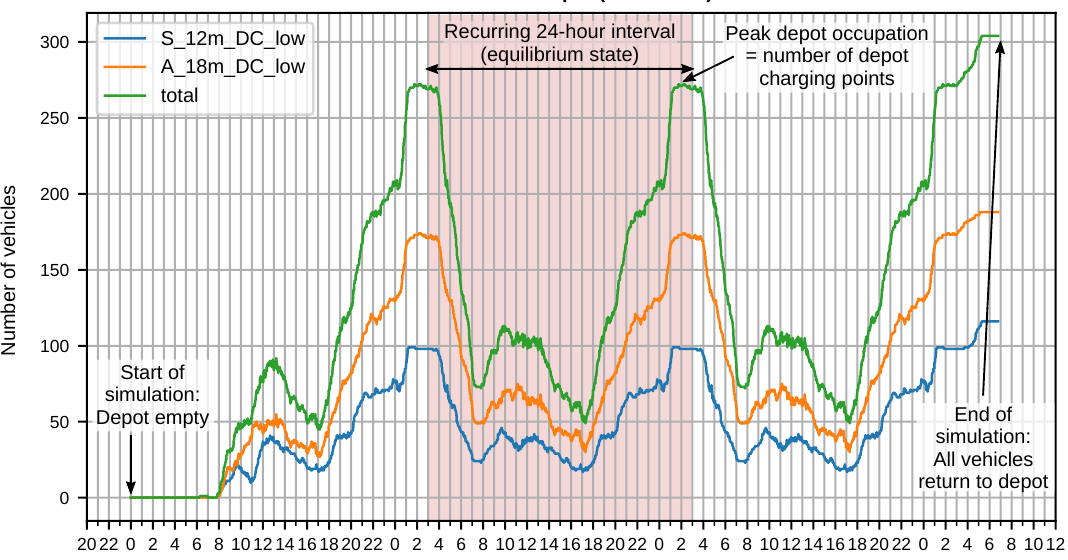
Figure 12. Using repeated schedules to obtain an equilibrium state in the bus